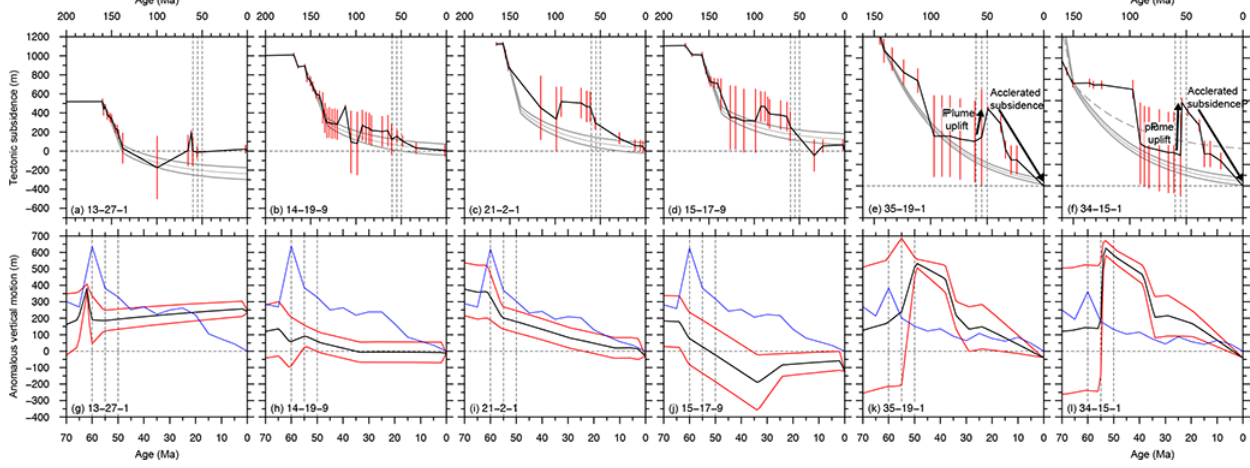
Figure 9. Top panels (a–d) : backstripped water-loaded tectonic subsidence histories from wells in the North Sea (locations given in Fig. 6; Clift and Turner, 1998), and Porcupine Basin ( e–f ; Jones et al., 2001) presented as in Fig. 7a. Bottom panels (g–l) : comparison between model dynamic topography and anomalous vertical motion curves presented as in Fig. 7b for the last 70Myr of top panels. Dotted line represents computed theoretical subsidence history from Jones et al. (2001) using their first-choice stretching factor of 1.27 for that particular well.